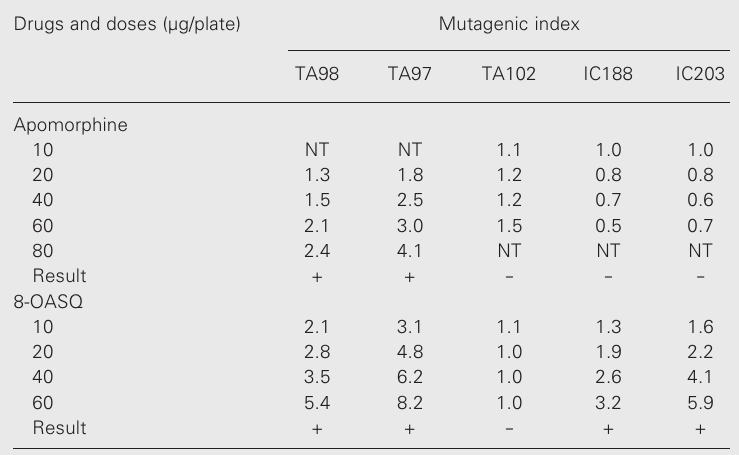
Table 1. Mutagenic effects of apomorphine and 8-oxo-apomorphine-semiquinone (8- OASQ) in bacterial strains detecting frameshift ( S. typhimurium TA98 and TA97 strains) and oxidative mutagens ( S. typhimurium TA102 strain and E. coli IC188 and IC203 strains), without metabolic activation (S9